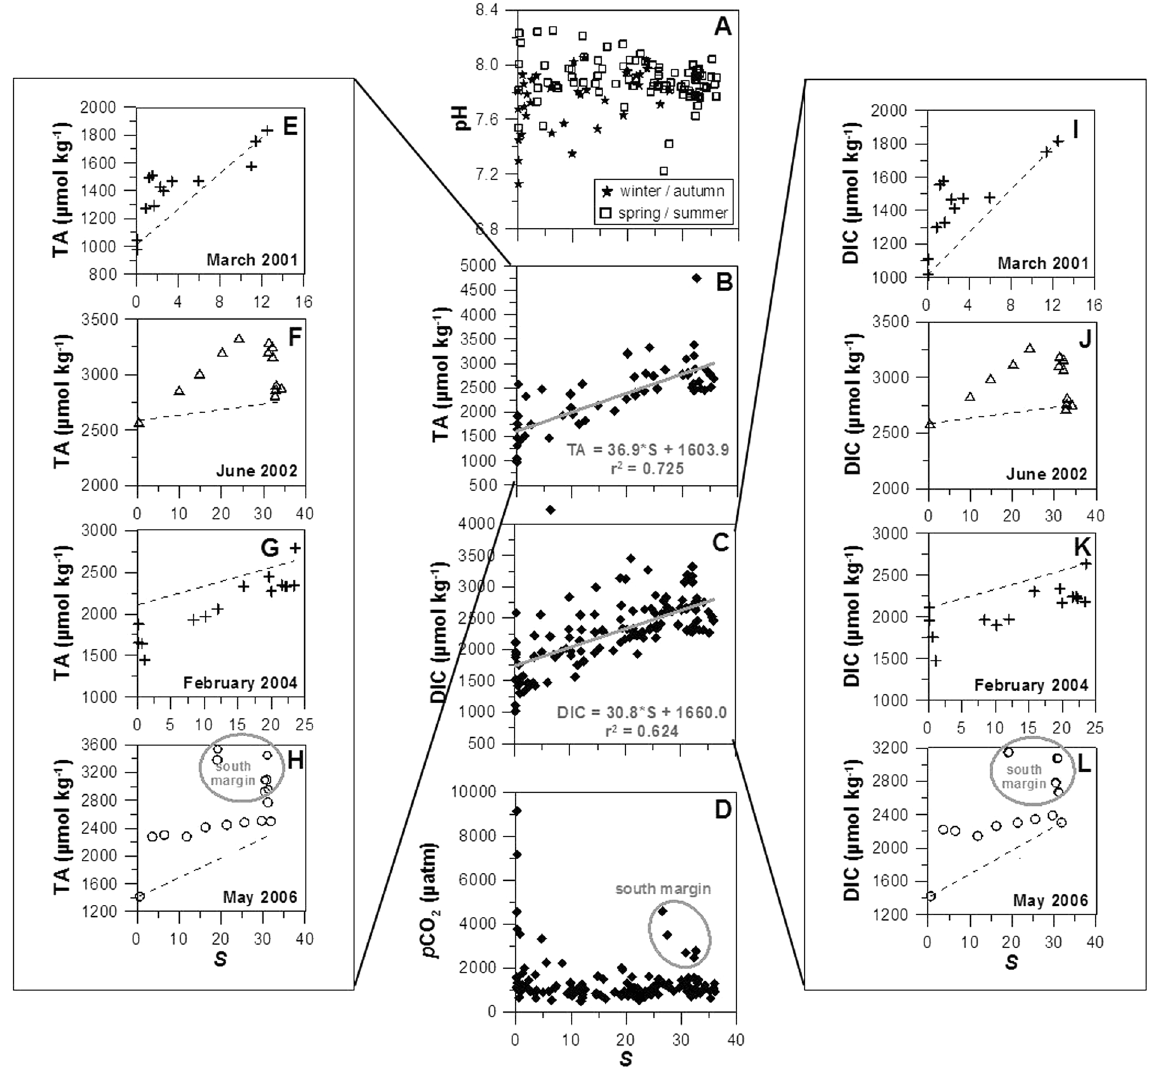
Figure 5. Mixing curves for ( A ) pH, ( B ) total alkalinity (TA), ( C ) dissolved inorganic carbon (DIC) and ( D ) CO 2 partial pressure ( p CO 2 ) for all 10 surveys data undertaken in Tagus estuary. TA anomalies in ( E ) March 2001, ( F ) June 2002, ( G ) February 2004 and ( H ) May 2006. DIC anomalies in ( I ) March 2001, ( J ) June 2002, ( K ) February 2004 and ( L ) May